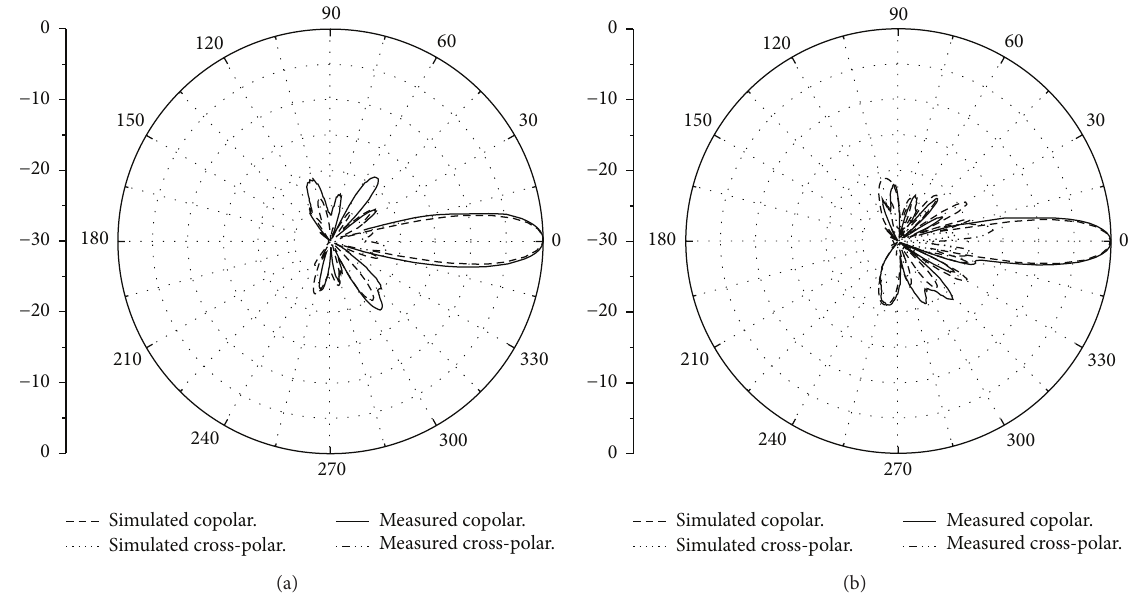
Figure 8: Measured and simulated radiation patterns on the 𝑋𝑍 plane and 𝑌𝑍 plane: (a) 𝑋𝑍 plane; (b) 𝑌𝑍 plane.